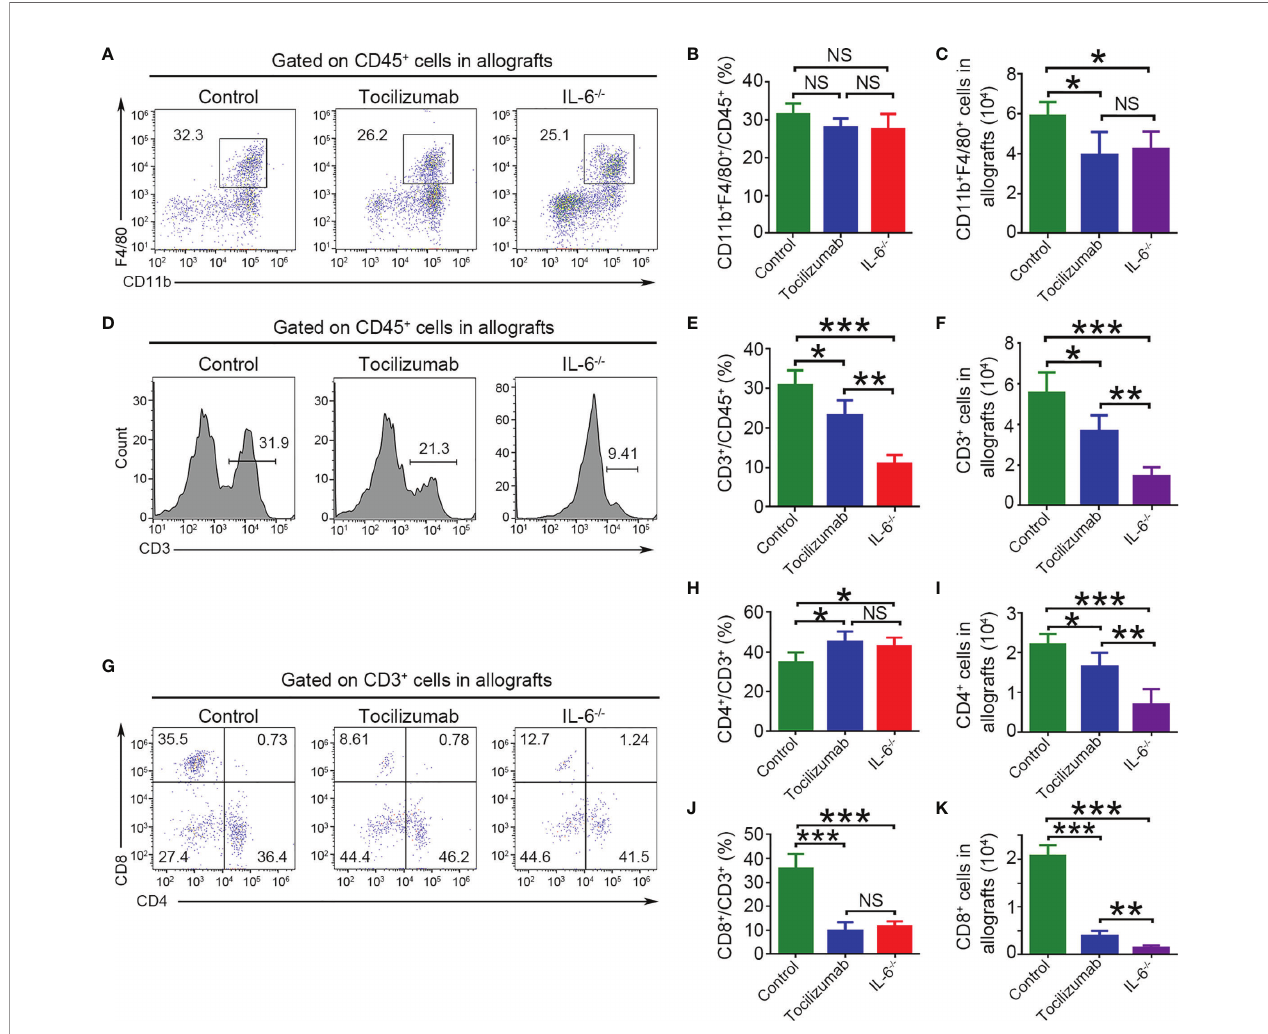
FIGURE 5 | Blockade of IL-6/IL-6R signaling reduces macrophages and T cells in fi ltration in allografts detected by fl ow cytometry. Macrophages (CD11b + F4/80 + ), T cells (CD3 + ), CD4 + T cells (CD3 + CD4 + ), and CD8 + T cells (CD3 + CD8 + ) were detected in allografts 4 d after transplantation in the control, tocilizumab, and IL-6 -/- groups. Representative dot plots for frequencies and quantitative analysis of frequencies and counts of macrophages (A – C) , T cells (D – F) , CD4 + T cells and CD8 + T cells (G – K) (n = 4/group). *P<0.05; **P<0.01; ***P<0.001; NS, no signi fi